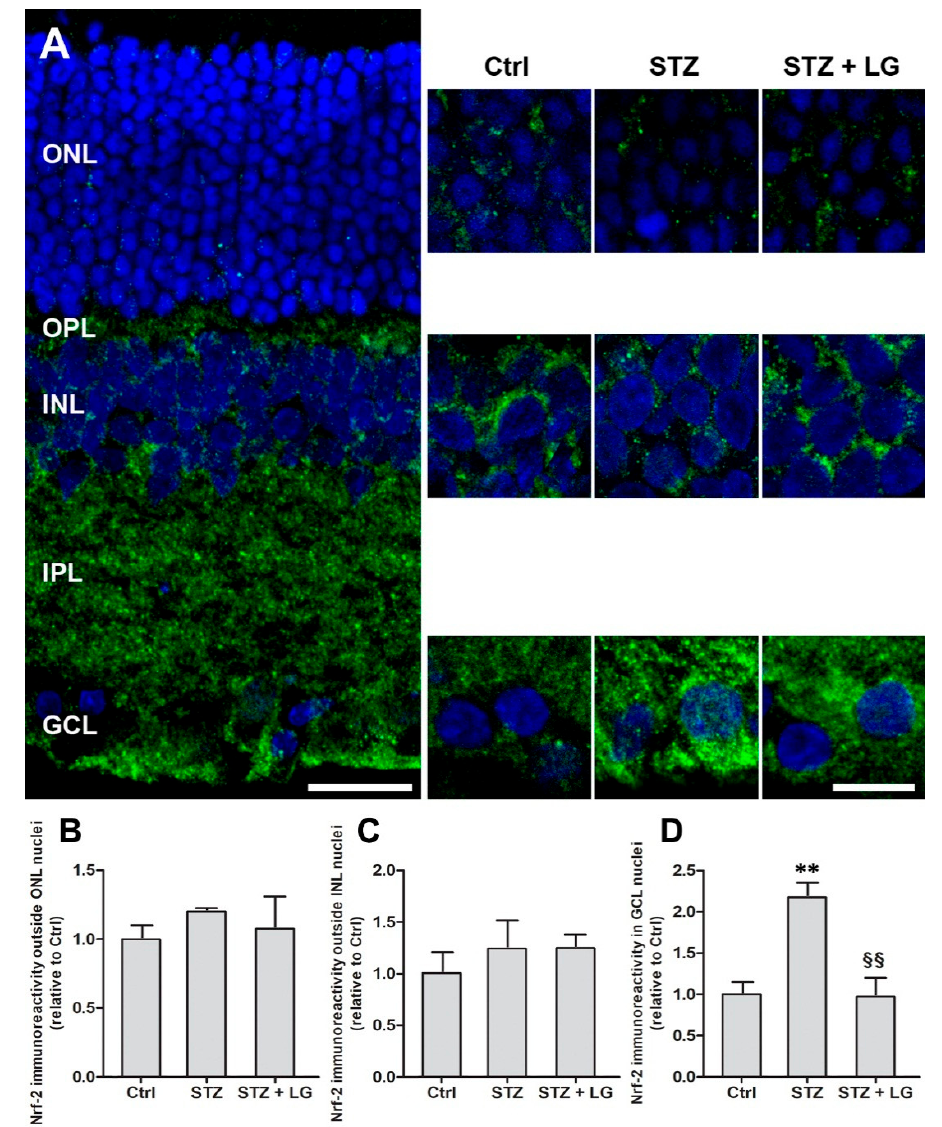
Figure 10. ( A ) Nuclear factor erythroid 2-related factor 2 (Nrf2) immunostaining patterns observed with the ApoTome microscope in coronal retinal sections of control rats, STZ rats, and STZ rats treated with LG. Left panel: low power extended focus image of a retinal section of a control rat showing extensive Nrf2 immunolabeling throughout the retinal layers. Scale bar, 20 μ m. Right panels: higher power images of single focal planes showing changes in Nrf2 immunostaining in the ONL, INL, and GCL in the three experimental conditions. Scale bar, 10 µ m. ( B – D ) Quantitative analysis of Nrf2 immunofluorescence levels in non-nuclear regions of the ONL ( B ) and of the INL ( C ) and within cell nuclei in the GCL ( D ). Each column represents mean ± SD. ** p < 0.01 vs. Ctrl; §§ p < 0.01 vs. STZ; n = 4 for all measures. Power value: 0.94.